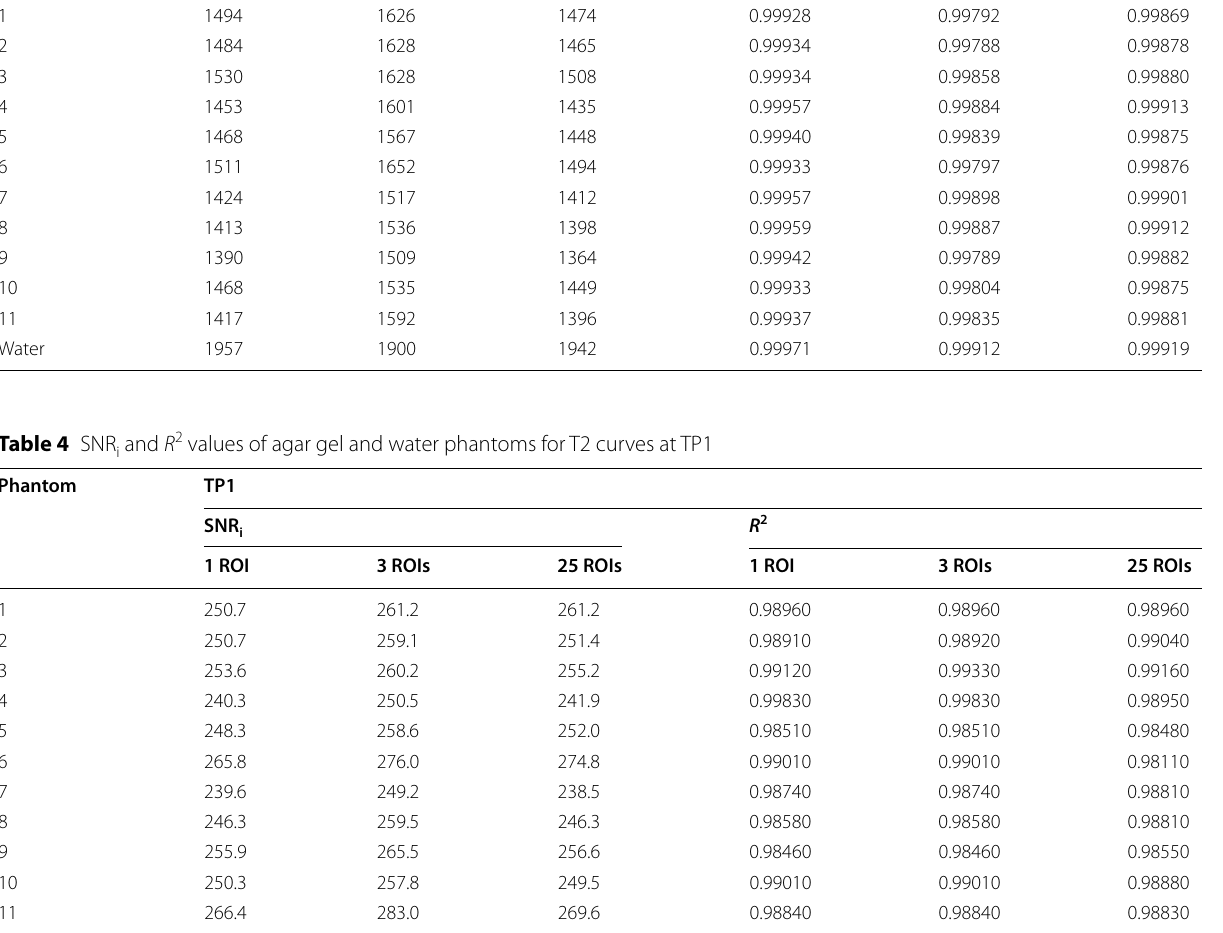
Table 3 SNR and R 2 values of agar gel and water phantoms for T1 curves at TP2 o Phantom TP2